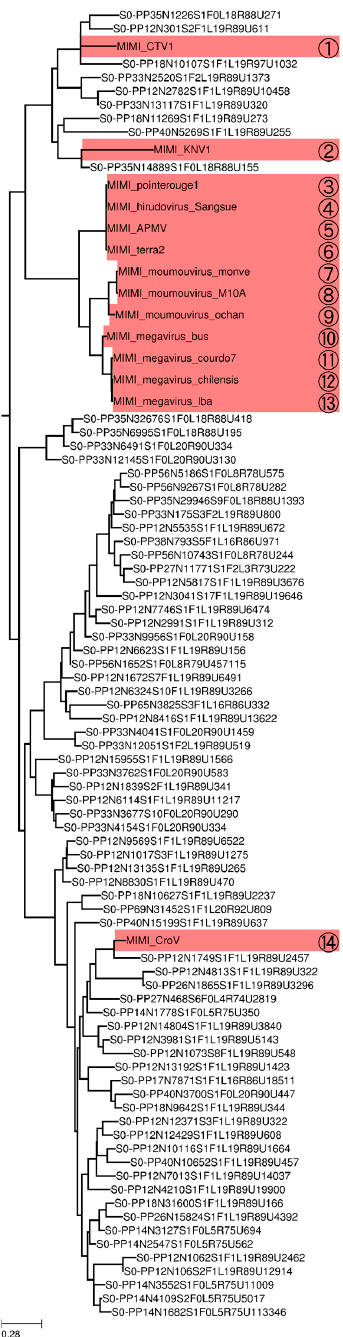
Figure 6. Phylogenetic sub-tree of PolB meta-barcodes. A magnified view of the phylogenetic tree around the Megamimivirinae group in Figure 5 is presented. The branch lengths are scaled. Reference genomic genes are indicated by the corresponding numbers in Figure 5.